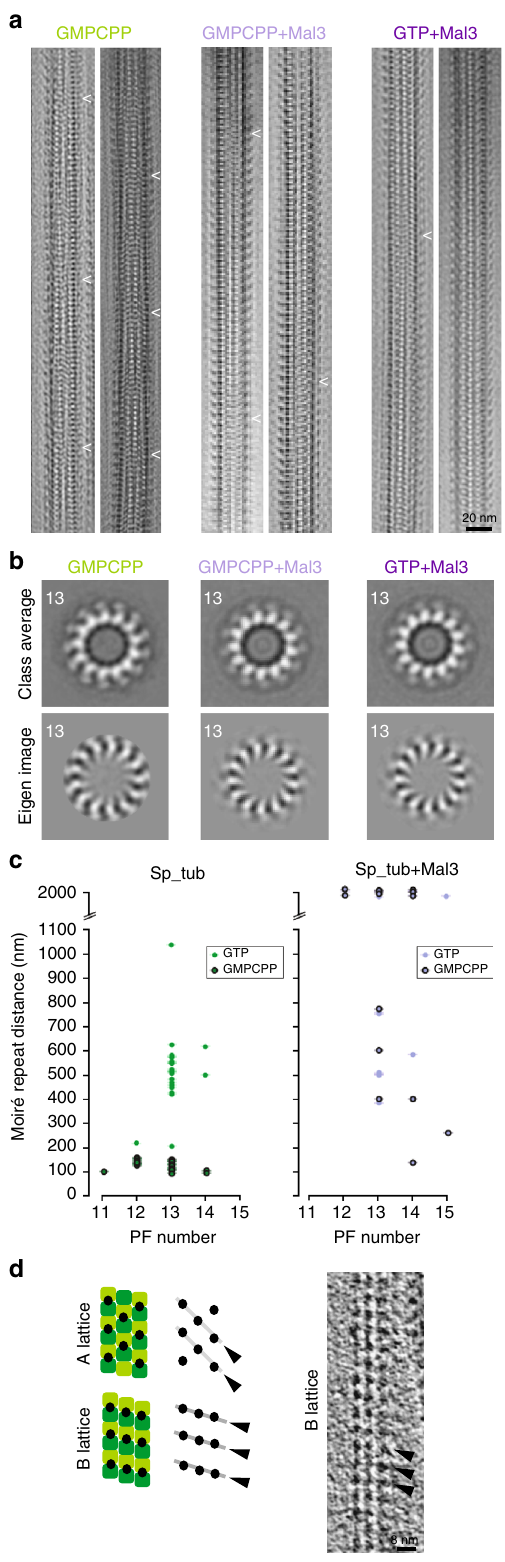
Fig. 1 Sp_tub MT polymerization architecture and modulation by Mal3. a Fourier- fi ltered cryo-EM MT images of S. pombe tubulin polymerized in different conditions as indicated, with a kinesin motor domain added to facilitate characterization of MT architecture. Arrowheads indicate the underlying moiré pattern of each MT. Scale bar = 20 nm. b Example class averages and eigen images of 13-PF Sp_tub MTs (among the other PF architectures present) derived from tomograms using multivariate statistical classi fi cation. Views presented for the given polymerization conditions in a , b are not the same MT. c Relationship between PF number and moiré repeat length according to the polymerization conditions of Sp_tub. d Top, MT A/B-lattices ( α -tubulin, dark green, β -tubulin light green), depicted schematically in the presence of KMDs (black circles); bottom, longitudinal section from a tomogram (an example from the GMPCPP+ Mal3 data set is shown) allowing visualization of a B-lattice-like KMD arrangement. Scale bar = 8